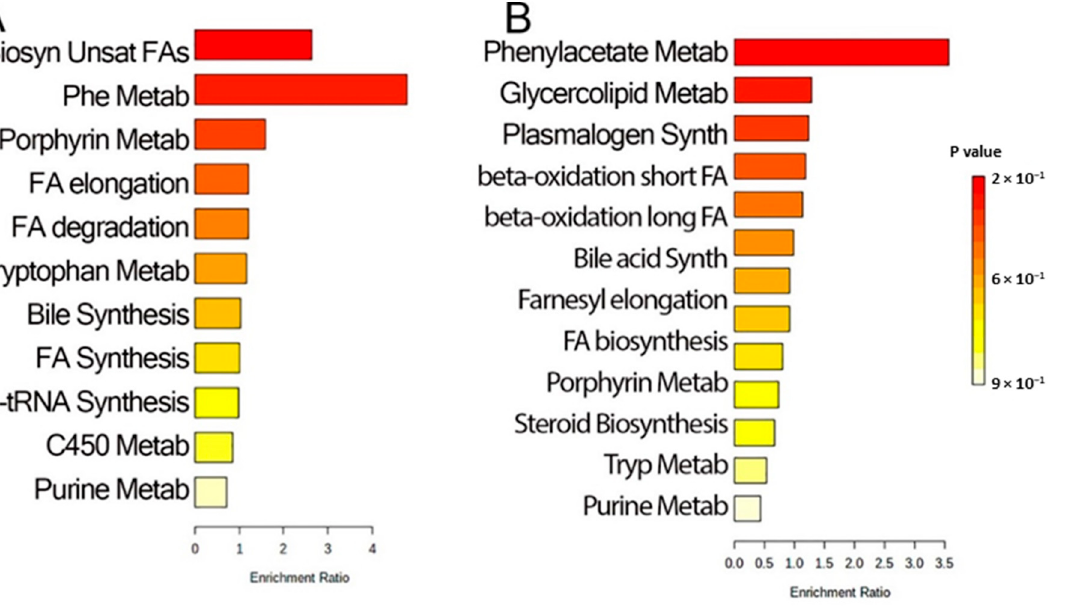
Figure 4. Pathway analysis. A total of 72 identified metabolites were analyzed for pathway enrich- ment in MetaboAnalyst 5. The bars represent the pathway ratio, representing the fraction of metab- olites in the BALF data set relative to that of the entire pathway. Significance of enrichment is indi- cated by color, as indicated in the scale on the right. ( A ) KEGG library. ( B ) SMPDB library. Note that saturated fatty acid synthesis and metabolism are highly enriched in both analyses.